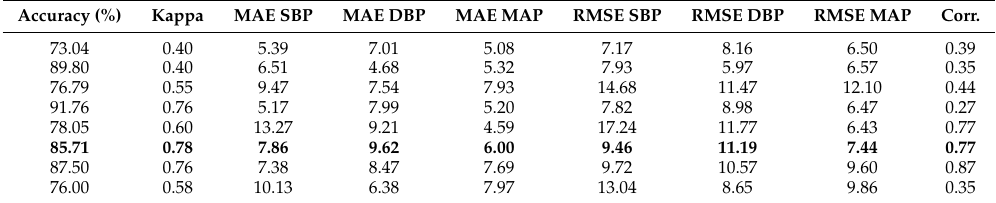
Table 5. Classification and regression models evaluation on validation